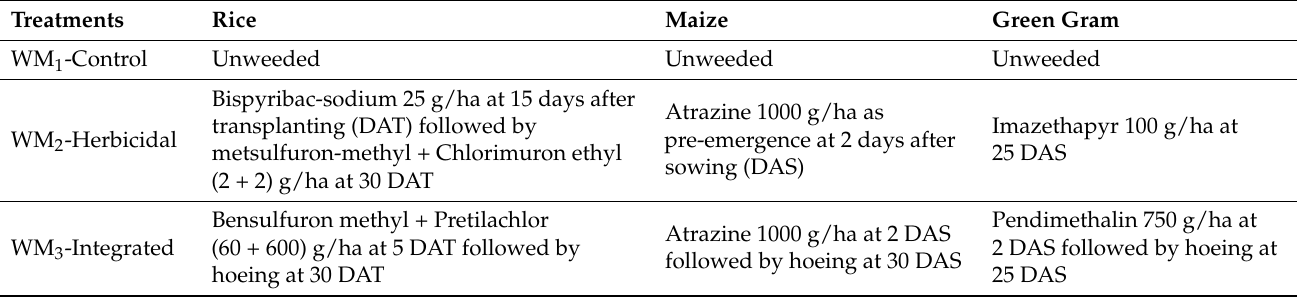
Table 1. Weed management practices in different crops under the rice–maize–green gram system. Treatments